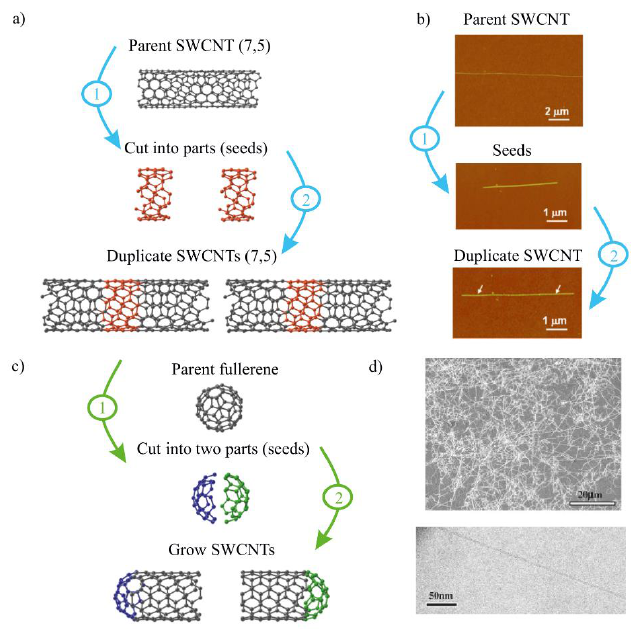
Figure 10. ( a ) Schematic of a cloning for the growth of identical SWCNTs from SWCNTs. At the first step, as-grown ultralong single-chirality SWNTs cut into shorter segments, seeds (red in color). At the second step, the grown SWNTs could be grown from the obtained seeds with activated edges. ( b ) The experimental implementation of the cloning method presented on figure ( a ). The duplicate SWNTs continued to grow from the seeds obtained from a parent SWCNT [60]. Copyright 2010, American Chemical Society. ( c ) Two-step cloning method of identical SWCNTs from fullerenes. The parent fullerene is cut in half. Each of the obtained parts is used to grow new SWCNTs. ( d ) Representative SEM image ( top ) and TEM image ( bottom ) of the SWCNTs grown from fullerenes on a SiO 2 /Si substrate [63]. Copyright 2003, with permission from Elsevier.